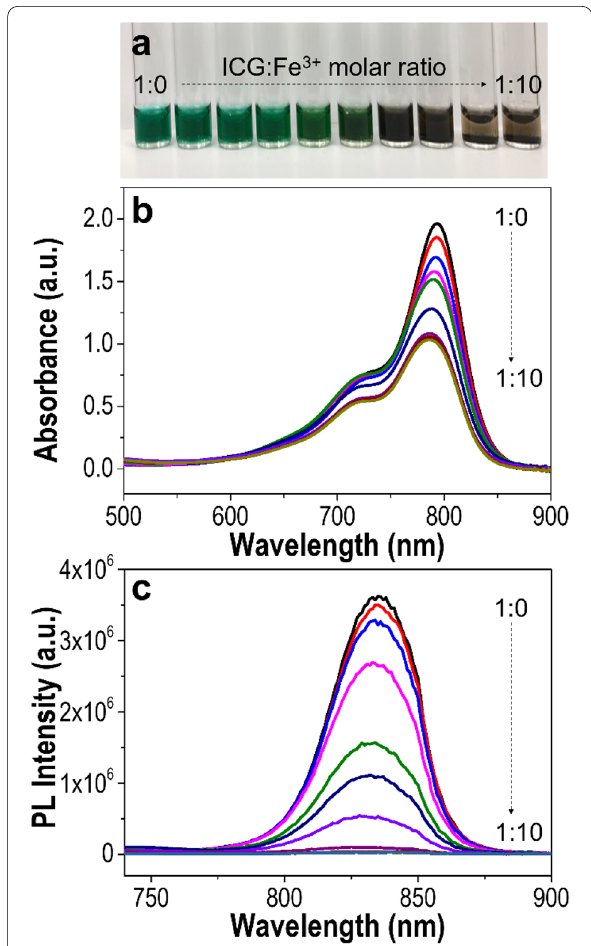
Fig. 2 Characterization of the ICG‑Fe complex. a Photograph of the ICG‑Fe complex in water as a function of the ICG:Fe 3 + molar ratio ranging from 1:0 to 1:10, and b , c their spectra in methanol: b UV/Vis absorption and c fluorescence emission (λ ex